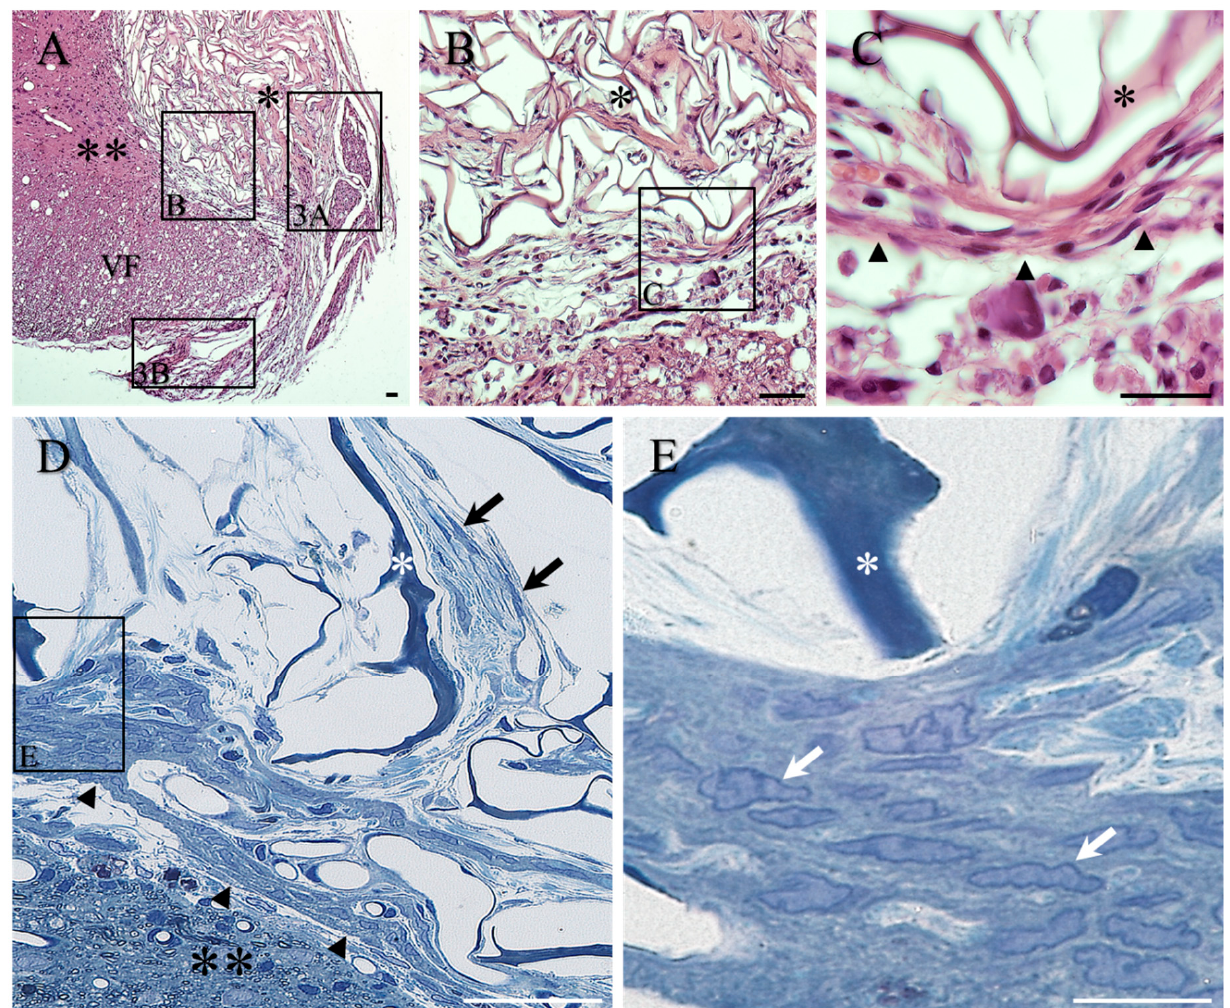
Figure 3. Morphology of implanted collagen scaffold in transverse sections stained with H&E ( A – C ) and for toluidine blue in semi-thin sections ( D , E ). ( A ) Low-magnification image of implanted scaffold (single asterisk) reveals the convoluted framework of the collagen scaffold and demonstrates the apparently good contact with the surrounding host spinal cord tissue (double asterisks). For orientation, the ventral funiculus is indicated by VF. Boxed area of the transition zone shown at higher magnification in Figure 2B. Other boxed areas shown at higher magnification in ( A , B ). ( B ) The presence of a conspicuous band of overlapping, elongated cells formed a transition zone at the interface between the collagen scaffold (asterisk) and the surrounding host tissue. Boxed area shown at higher magnification in ( C ). ( C ) Higher magnification of the band of the multiple overlapping cells (black arrowheads) coursing between the edge of the implant (asterisk) and the surrounding spinal cord tissue. ( D ) The morphology of the band of cells forming the transition zone around the implanted scaffold was more clearly seen in the toluidine blue semi-thin sections (black arrowheads). The darkly stained framework of the collagen scaffold (asterisk) highlights the open, porous nature of the scaffold with multiple, fine fibroblasts coursing amongst the palely stained collagen ECM deposits (black arrows). The overlapping cells and processes of the transition zone (arrowheads) separate the scaffold from the adjacent spinal cord parenchyma (double asterisk). ( E ) At high magnification, the uniform nuclear morphology of the tightly packed cells is apparent (white arrows). This observation is strikingly similar to the nuclear morphology of the cells in the lateral tissue bridge of the control group (compare with Figure 1F). Scale bars: A – D = 50 µ m; E = 20 µ